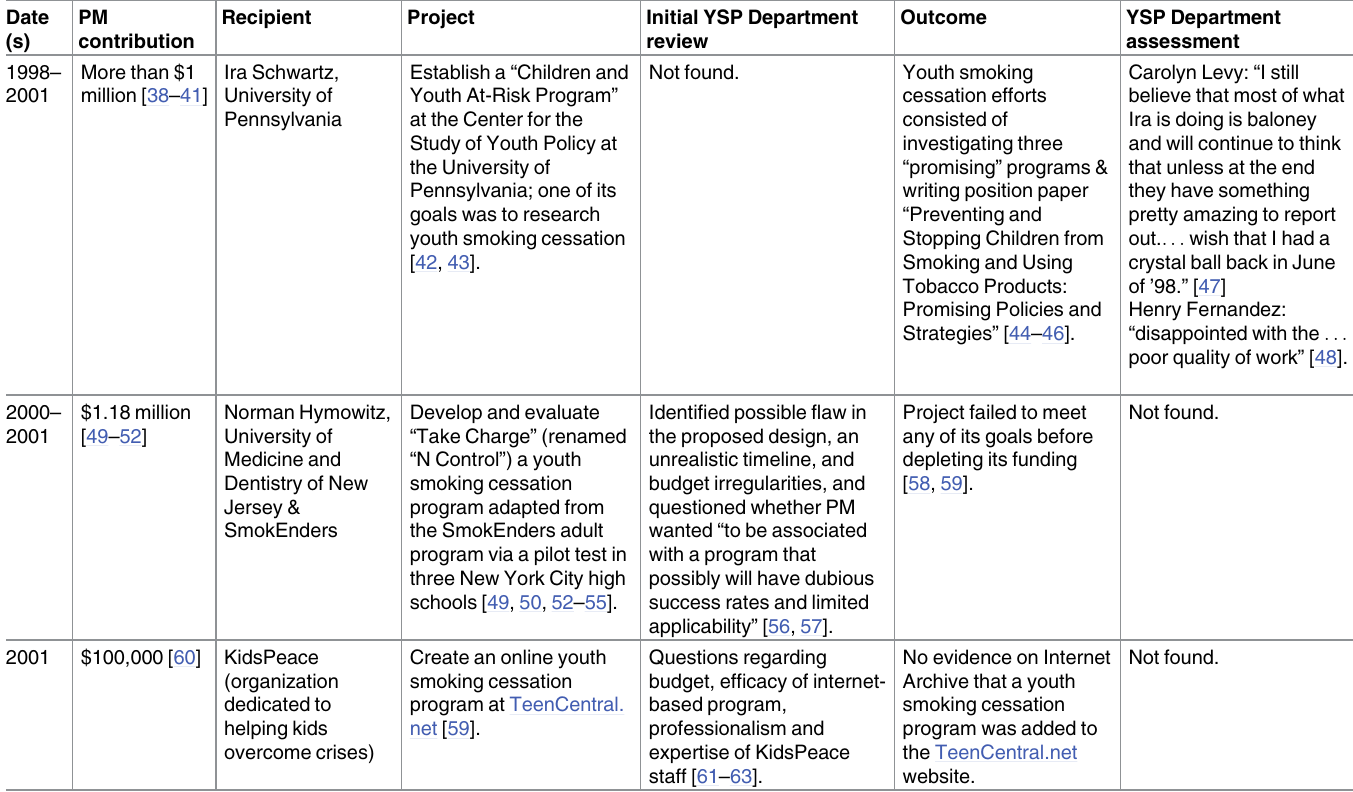
Table 1. Examples of Philip Morris USA’s Youth Smoking Prevention Department’s early support for youth cessation programs,